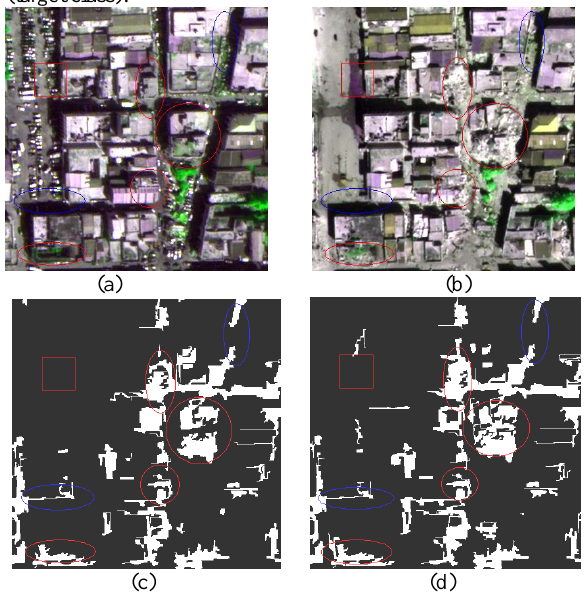
Figure 7 A close-up look of the building damage detection result by the OCSVM using different methods: (a) a local neighborhood on pre-quake imagery; (b) the neighborhood on post-quake imagery; (c) detection result, using comparative method; (d) using hierarchical multi-level method proposed in this study; Color assignments: white: building collapsed, black: uncollapsed. Within red circle: collapsed, within blue circle: